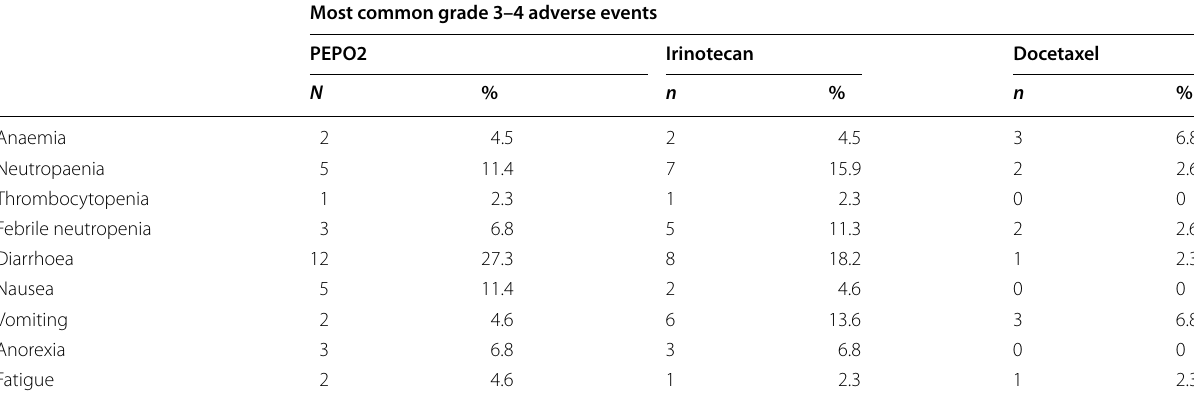
Most common grade 3–5 adverse events observed in a phase II study of liposomal irinotecan (PEP02), comprised of a liposomal irinotecan, irinotecan, and docetaxel arm